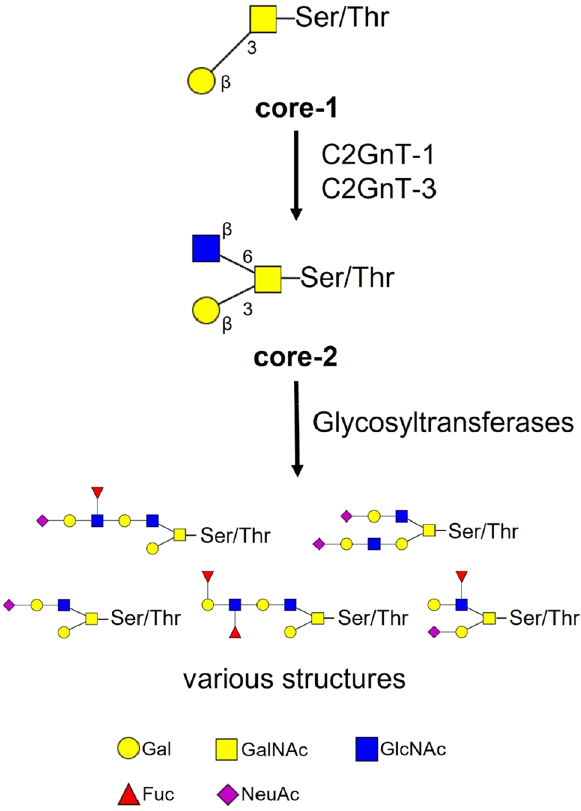
Figure 4. C2GnTs are the key enzyme for core-2 O -glycan biosynthesis. C2GnTs transfer a GlcNAc residue to the 6-position of GalNAc in core-1 disaccharide to form a core-2 trisaccharide. The core-2 trisaccharide is further modified by glycosyltransferases, including sialyltransferases and fucosyltransferases to turn various meaningful structures, such as the sialyl Lewis type, into a